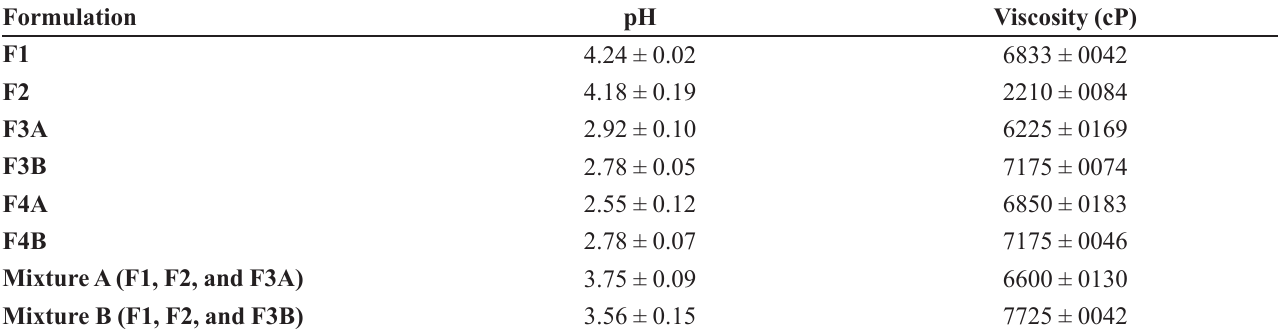
TABLE III – Mean pH and viscosity values of hydrogels